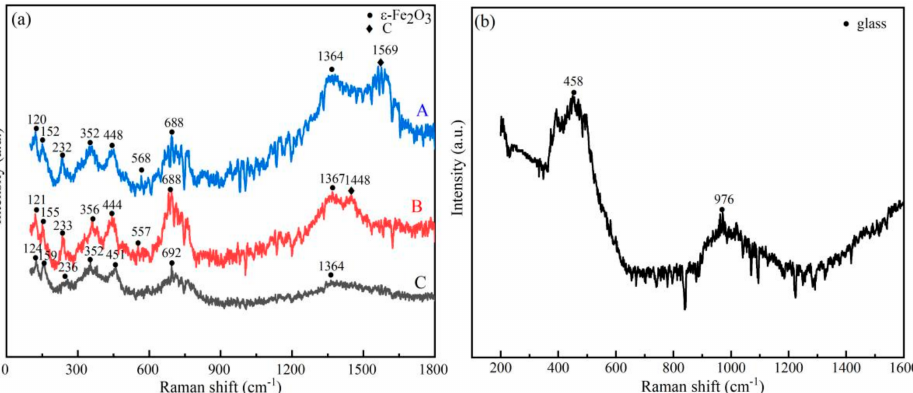
Figure 5. Raman spectra of the sample: ( a ) different spots at the yellowish-brown hare’s fur area; ( b ) black glaze